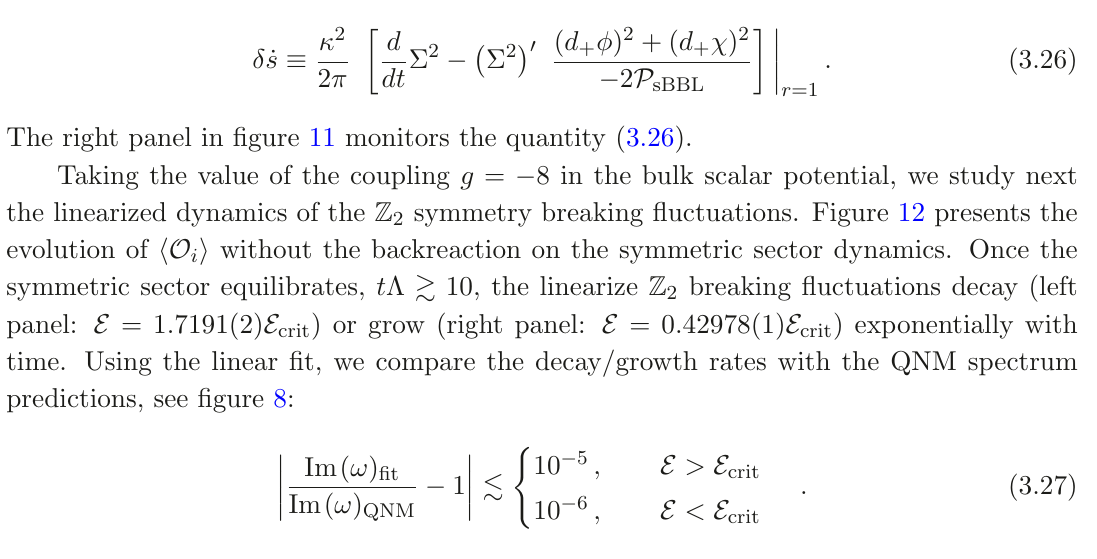
Figure 13 . Evolution of expectation values of in the unstable regime, i.e., with resolutions of the numerical